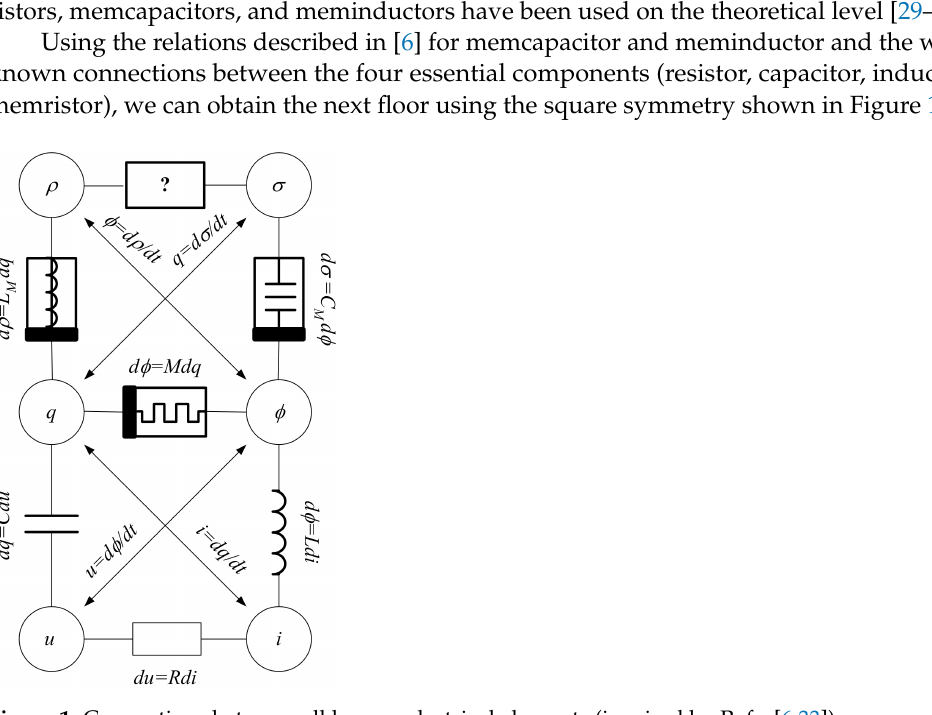
Figure 1. Connections between all known electrical elements (inspired by Refs. [6,33]). However, as we can observe in Figure 1, there could be some additional electrical element that has not been discovered